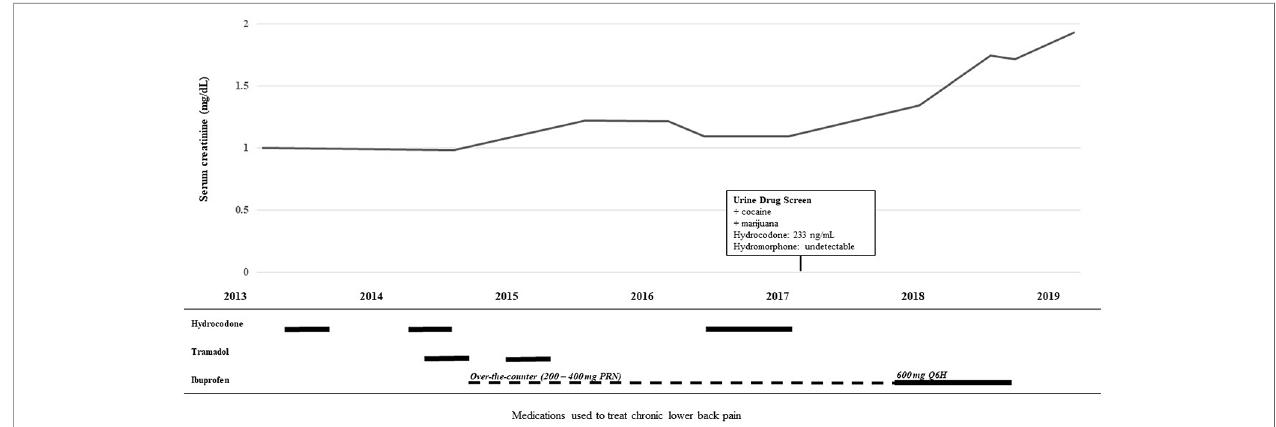
FIGURE 1 | Timeline of medication use and decline in renal function.The top line graph illustrates the rise in serum creatinine over time. The lower histogram illustrates the use of the analgesics hydrocodone, tramadol, and ibuprofen over the same time course. Solid lines depict the patient taking the drug for a consistent period of time and the broken line depicts the pro re nata (PRN) “ as needed ”